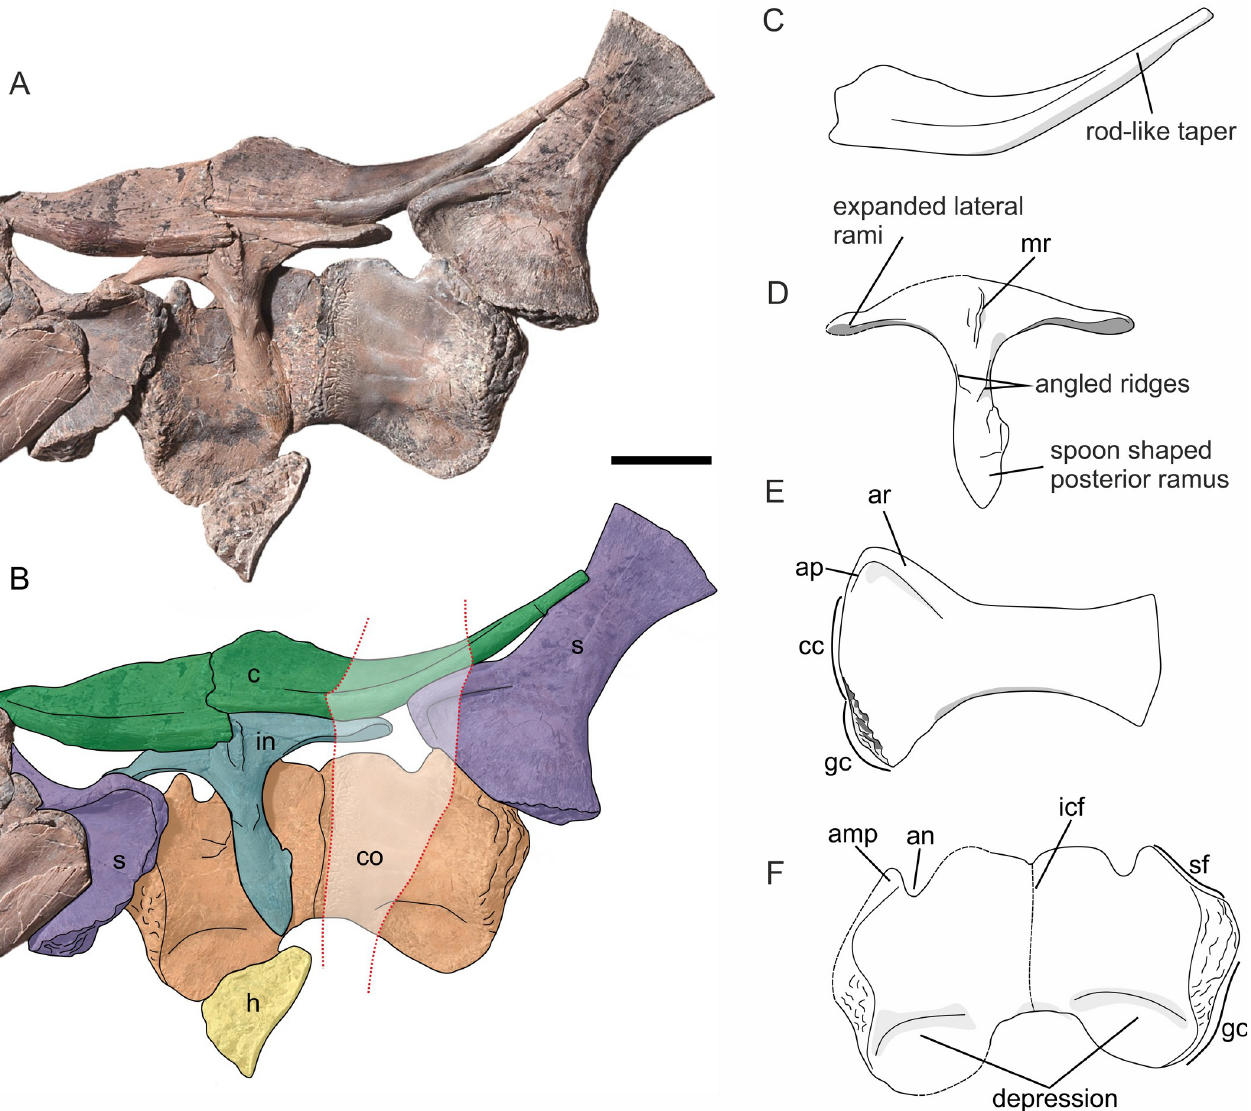
Fig 15. Pectoral girdle of Thalassodraco etchesi , MJML K1885. A, photograph of preserved pectoral girdle. B, line diagram of pectoral girdle. C, annotated line diagram of clavicle. D, annotated line diagram of interclavicle. E, annotated line diagram of right scapular. F, annotated line diagram of coracoids. For line diagrams, areas of restoration have been reconstructed from preserved portions of the pectoral girdle and personal observations. Abbreviations; amp, anteromedial process; an, anterior notch; ar, acromial ridge; ap, acromial process; c, clavicle; cc, coracoid contribution; co, coracoid; gc, glenoid contribution; h, humerus; icf, intercoracoid facet; in, interclavicle; mr, medial ridge; s, scapular; sf, scapular facet. Red dotted line indicates restored sections. Scale bar 100 mm.